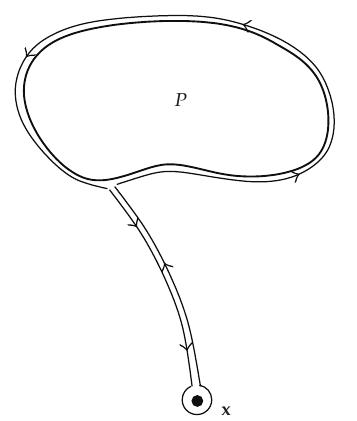
Figure 1: Integration path for studying the asymptotic behavior of the function G (cid:2) x (cid:3)